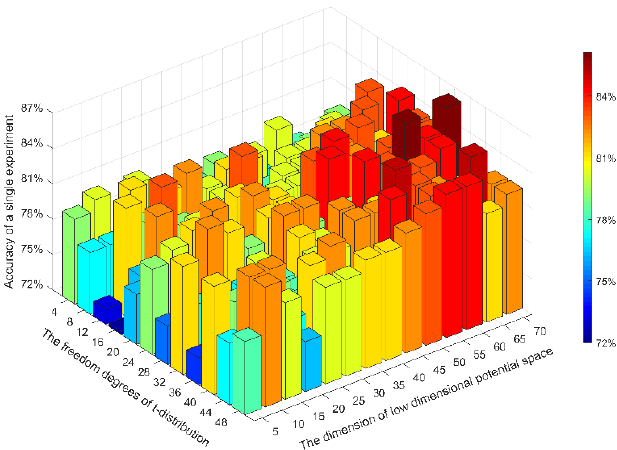
Figure 5 . The optimal selection of parameters 𝛼 and 𝑑 . Figure 5. The optimal selection of parameters α and d